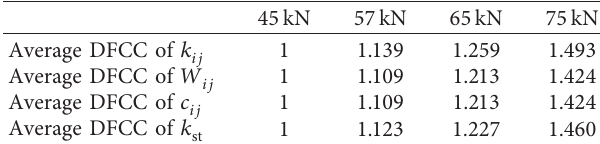
Figure 11: The curve of the damping ratio and interval statistics. (a) The curve of the damping ratio. (b) Chart of frequency distribution. Table 2: Arithmetic mean of DFCC under different